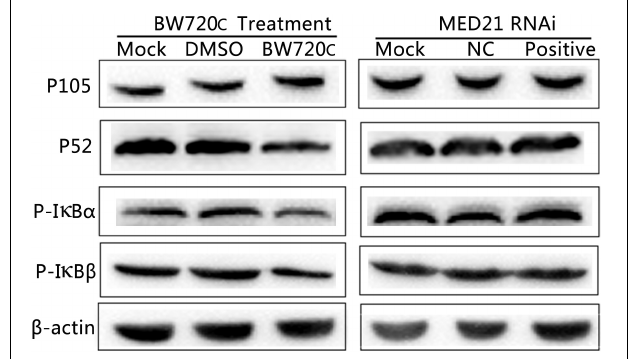
FIGURE 6 | Western blot analysis of cytoplasmic proteins in TaNM1 cells after BW720c treatment and MED21 RNAi. After BW720c treatment and MED21 RNAi, protein expressions of P105, P52, and Phosphorylated I κ B α / β proteins were detected using anti-NF- κ B1 P105, anti-NF- κ B2 P52, anti-phospho I κ B α and I κ B β antibodies. As reference protein, β -actin were detected using mouse anti- β -actin